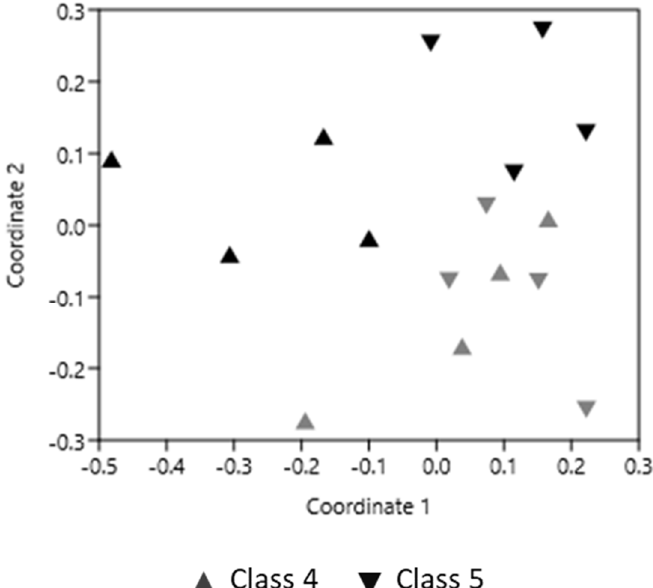
Figure 2. Two-dimensional nMDS ordination plots of PCR-DGGE profiles obtained by amplification of ciliate 18S rDNA from black pine deadwood samples of decay classes 4 and 5 collected in Pratomagno (black symbols) and Monte Morello (grey symbols) (stress = 0.19). The distance between the same symbols is inversely proportionated to the degree of similarity between ciliate community within a decay class.